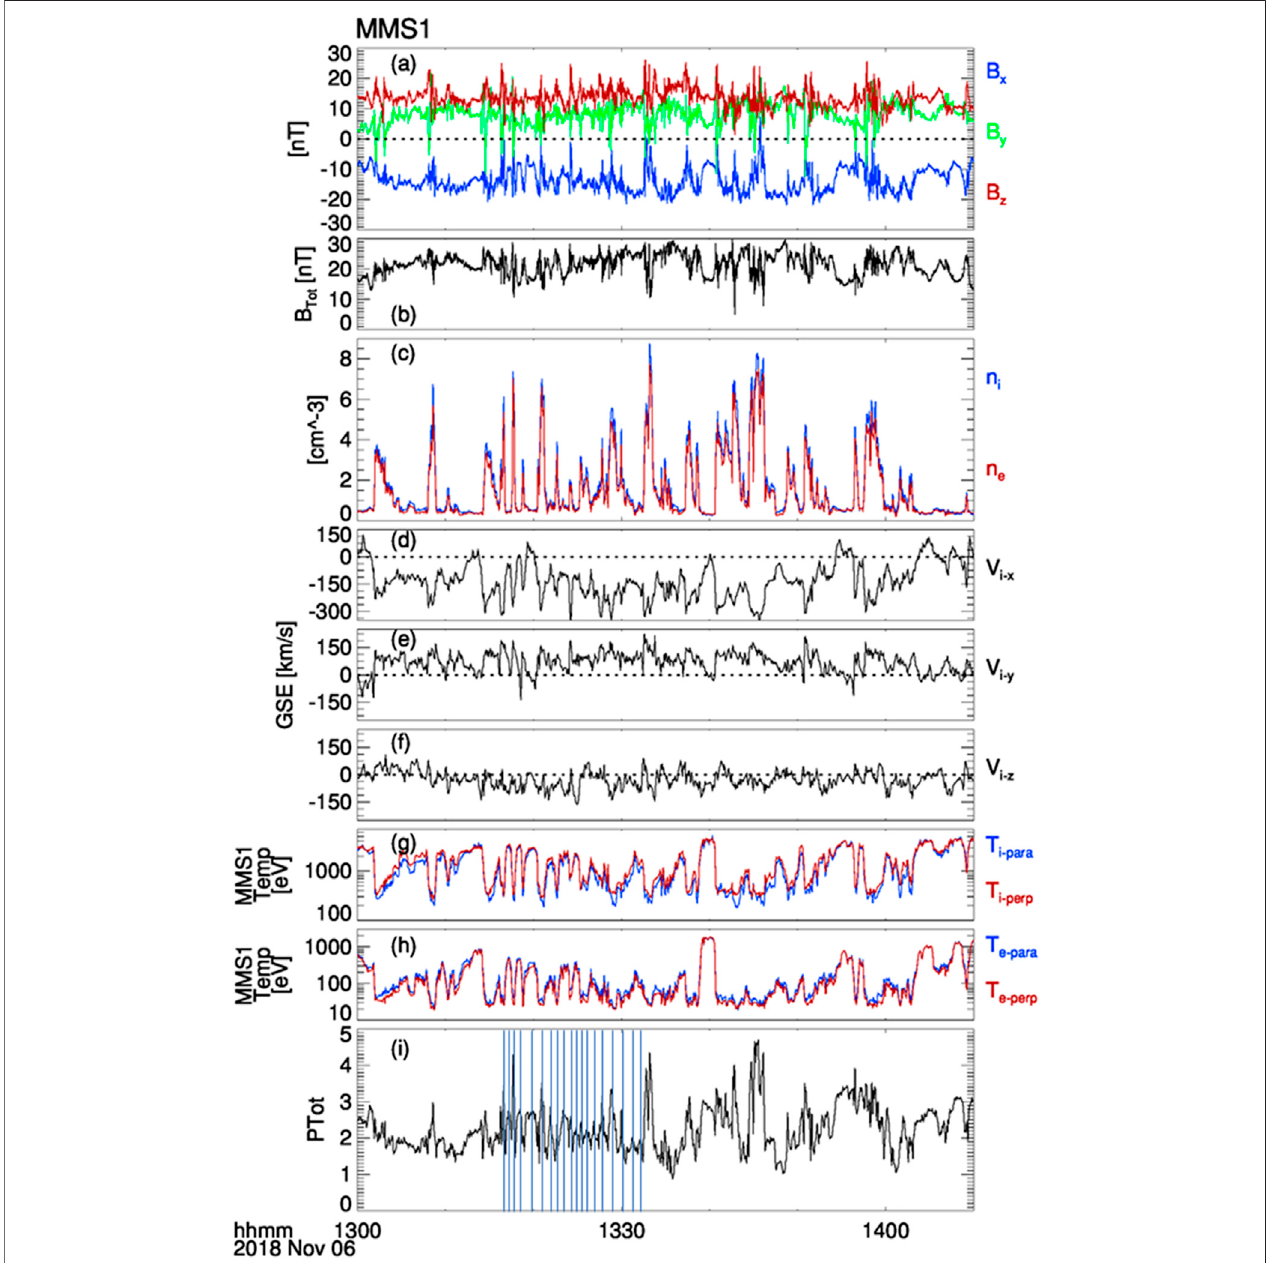
FIGURE 4 | Expanded view of sub-interval from Figure 3 . This sub-interval lies between the magnetosheath proper and magnetosphere proper, and shows several brief crossings of the magnetopause boundary. Panel format is the same as that of Figure 3 . Blue vertical lines in the bottom panel demark peaks of the static pressure.